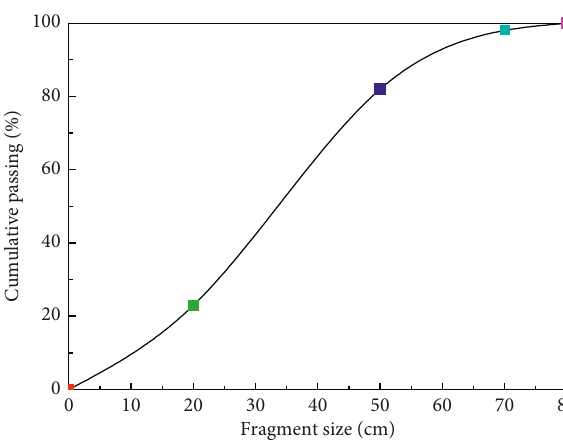
Figure 7: Fragment size distribution of the broken rock.